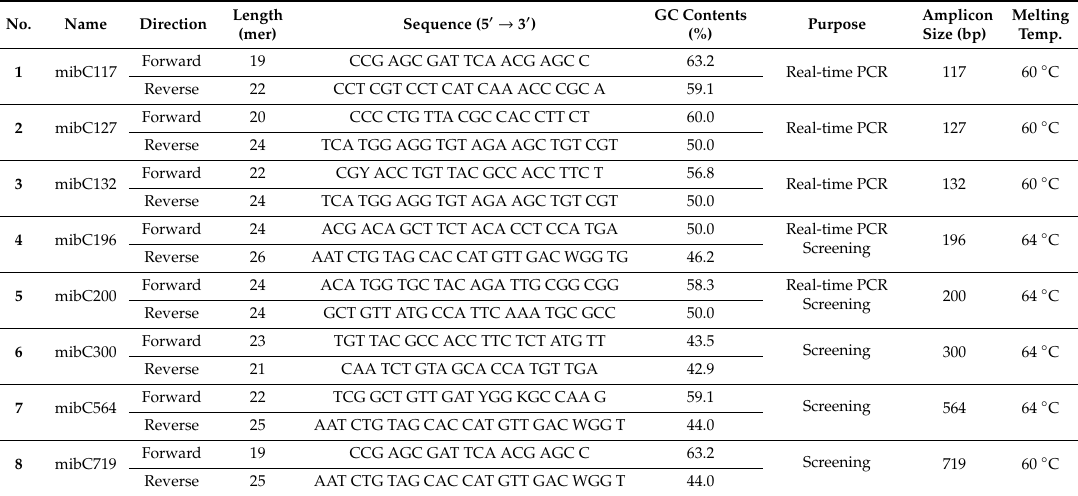
Table 1. Sequences of the designed primers targeting mibC to evaluate 2-methylisoborneol (2-MIB) production potential in